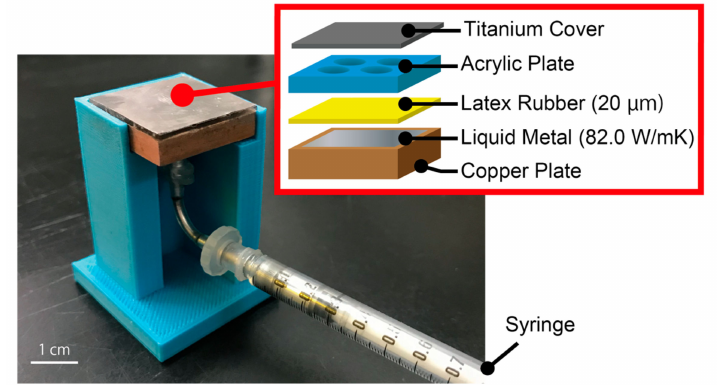
Figure 3. Structure of the thermal sensation tactile